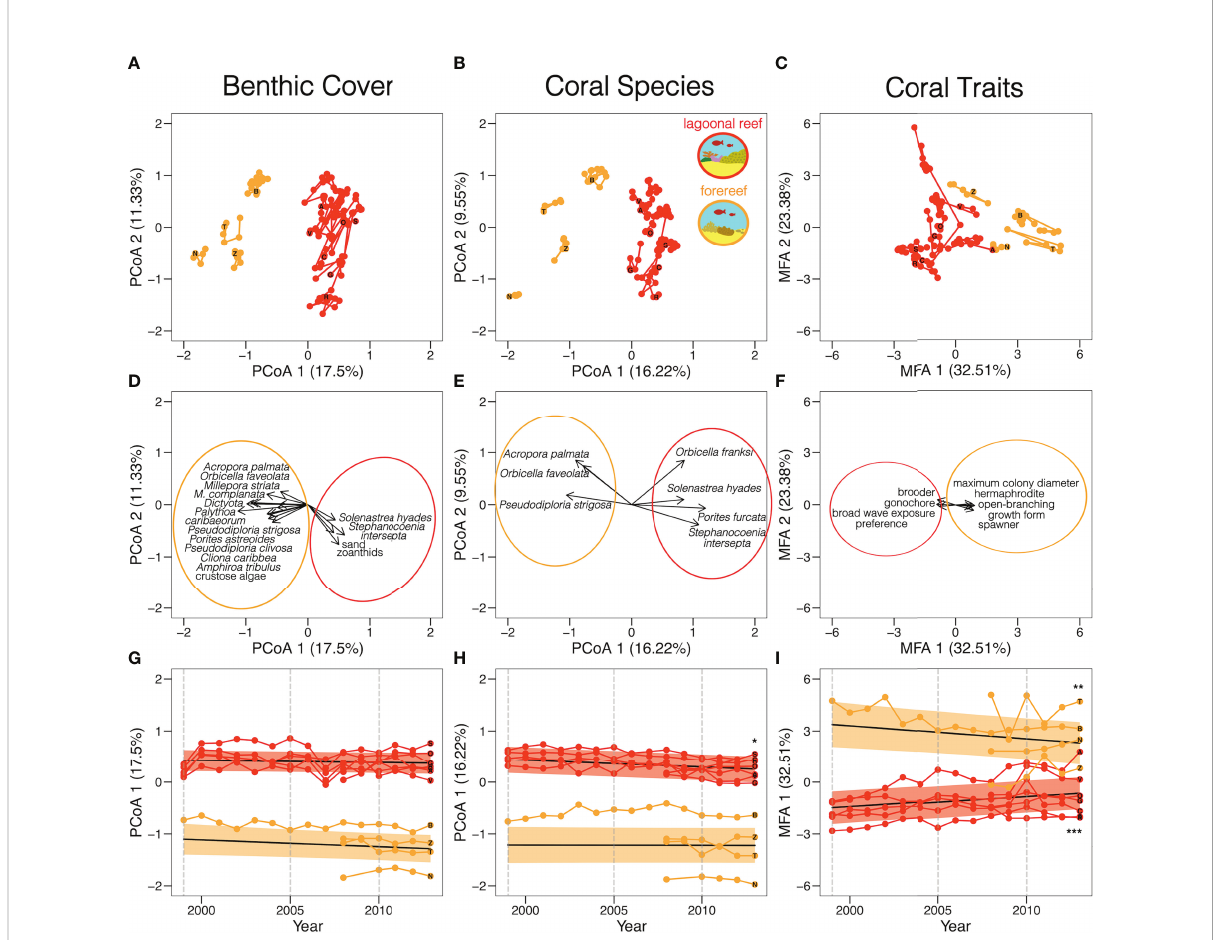
FIGURE 2 Variation in reef community composition and function across space and time. Colouring shows two spatially distinct types of reef communities differentiated by benthic cover (A, D, G) , coral species (B, E, H) , and coral traits (C, F, I) . Each point represents one of 11 reef communities in a given year. PCoA and MFA biplots show variation in all communities across all years (A-C) and the species most associated (D-F) . Coloured ellipses highlight the reef type associated with each species or trait. Timeplots show temporal variation in community composition along the fi rst PCoA and MFA axes (G-I) . Black lines represent the predicted trends and coloured bands represent standard error. Grey dashed lines mark the years during which bleaching events occurred in Bocas del Toro. Asterisks mark signi fi cant trends (*p <.05; **p <.01; ***p <.001). Letters represent reef locations and mark community composition in